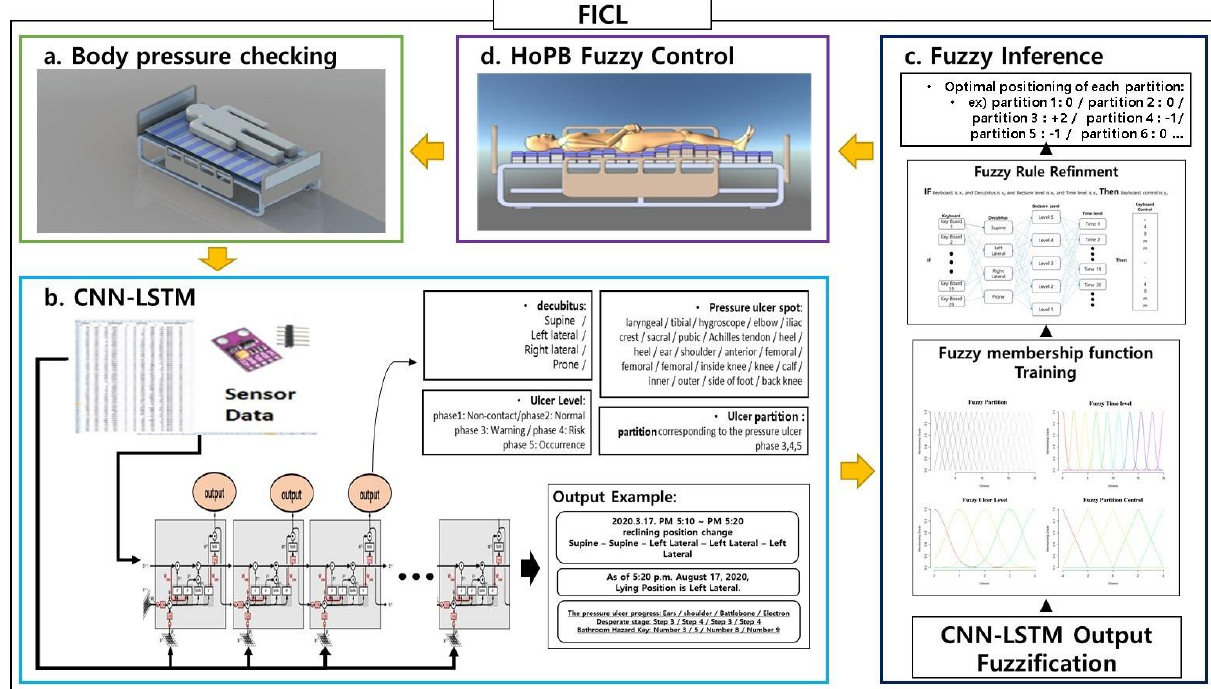
Figure 2. Schematic overview of the proposed FICL-based smart medical bed. This model has four stages: ( a ) body is checked with sensors embedded within the HoPB and data is collected over 80 s periods; ( b ) a multi-input ConvLSTM model then makes an analysis of the patients’ status; ( c ) this is then updated with fuzzy inference; ( d ) the HoPB of the bed is adjusted to prevent bedsores and pressure ulcers. (Ninebell Co., Ltd. provided smart bed pictures in this figure.).